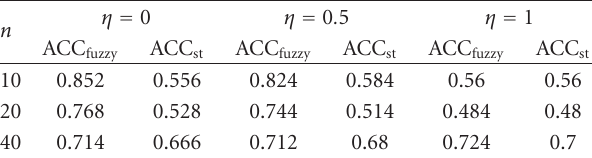
Table 1: Accuracy measures for di ff erent n and ν